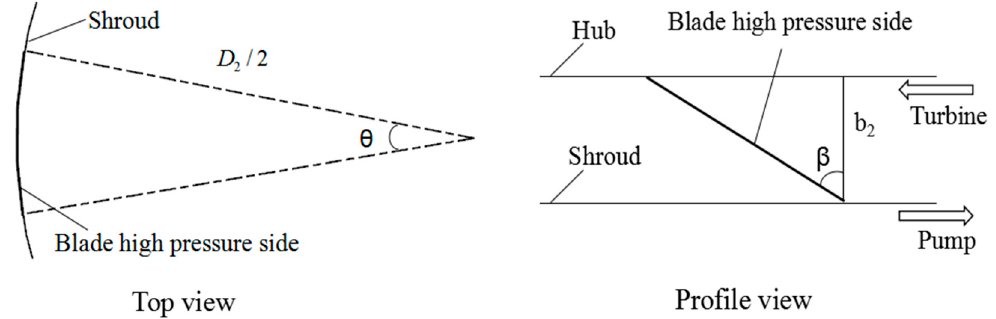
Figure 2. Blade lean at high pressure side.